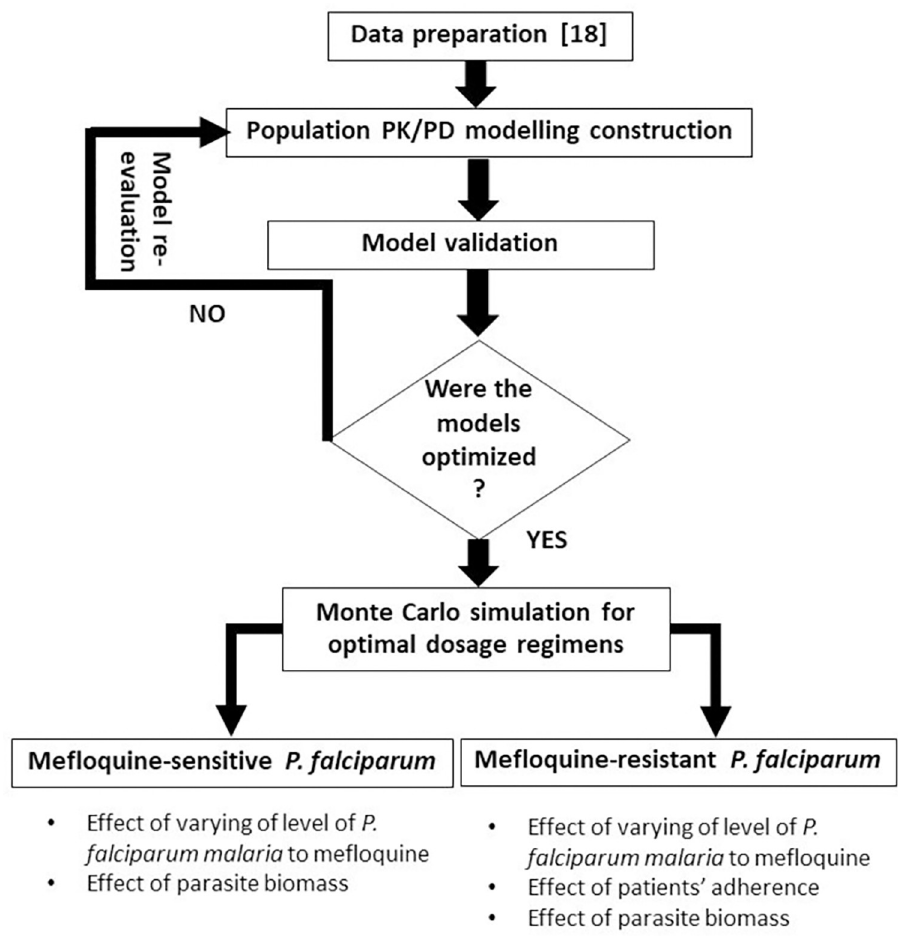
Fig 1. A flow-chart diagram of materials and